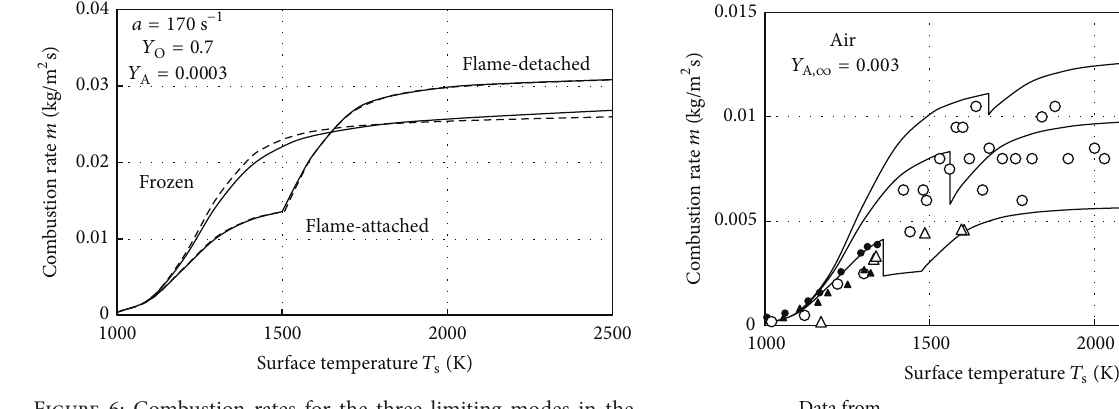
Figure 6: Combustion rates for the three limiting modes in the stagnation oxidizer flow as a function of the surface temperature. The solid curves are numerical results and dashed curves are those of the explicit expressions.